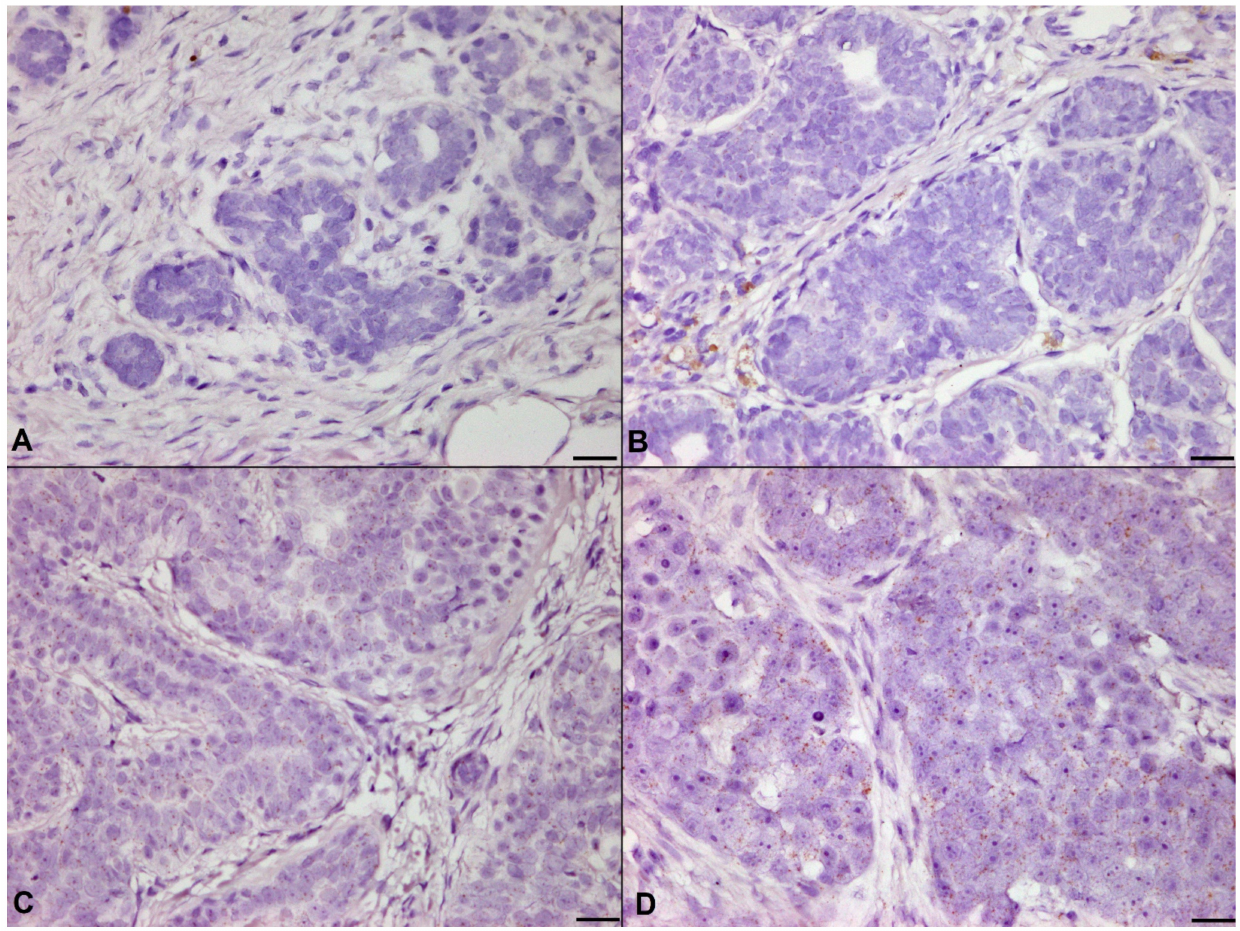
Figure 5. RNA in situ hybridization for Akt2. ( A ) Normal mammary gland. Brown dot represents a single transcript for Akt2, and a single or no RNA transcript was detected in normal glandular cells. ( B ) Mammary adenoma. Akt2 mRNA level was slightly increased or similar in mammary adenoma compared to normal mammary gland. ( C ) Mammary carcinoma, low-grade. Expression of Akt2 was comparable or mildly higher when compared to normal or mammary adenoma. ( D ) Mammary carcinoma, high-grade. Markedly higher expression of Akt2 transcripts was detected than those in the normal mammary gland. RNA in situ hybridization, counterstained with 50% Gill’s hematoxylin. Original magnification 400 × . Bar = 20 µ